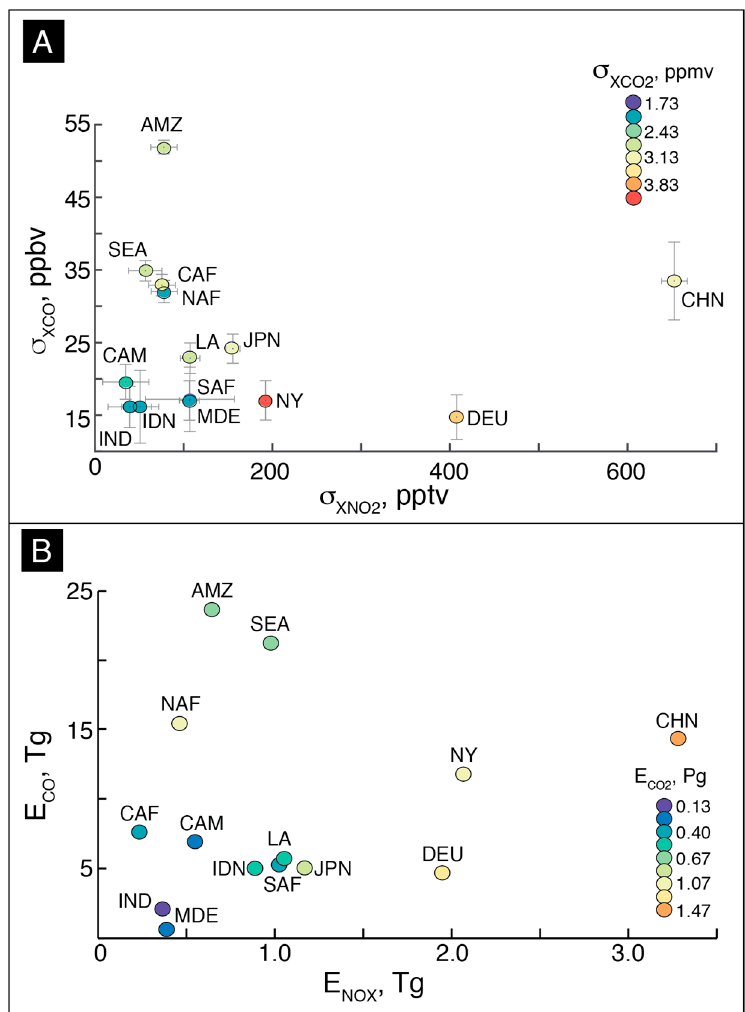
Figure 2. Regional-scale combustion signatures derived from: ( A ) spread of XCO 2 , XCO and XNO 2 satellite retrievals, and ( B ) emission estimates from EDGAR4.2 database with GFEDv3 fire emissions. Note that ( A ) and ( B ) have different units. Light line bars correspond to the range of our estimates in (see text for error calculation using boot-strap method).